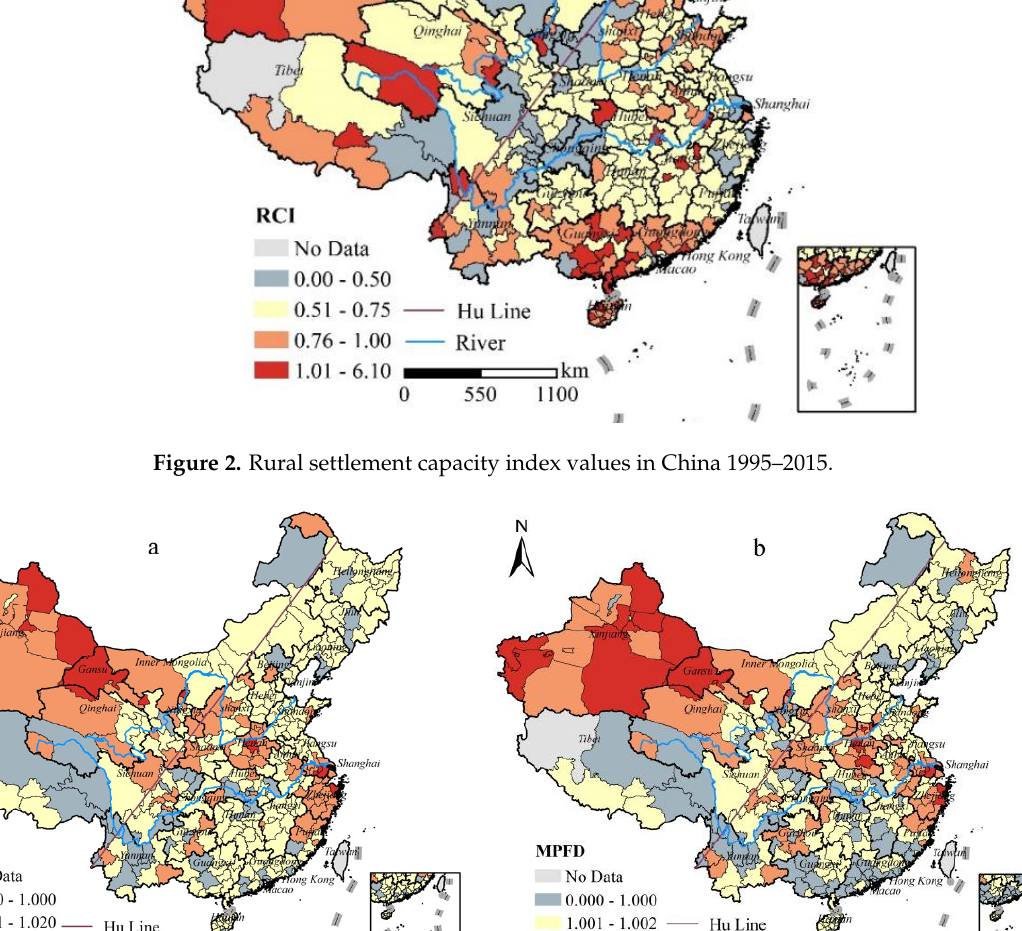
Land 2021 , 10 , x FOR PEER REVIEW 7 of 15